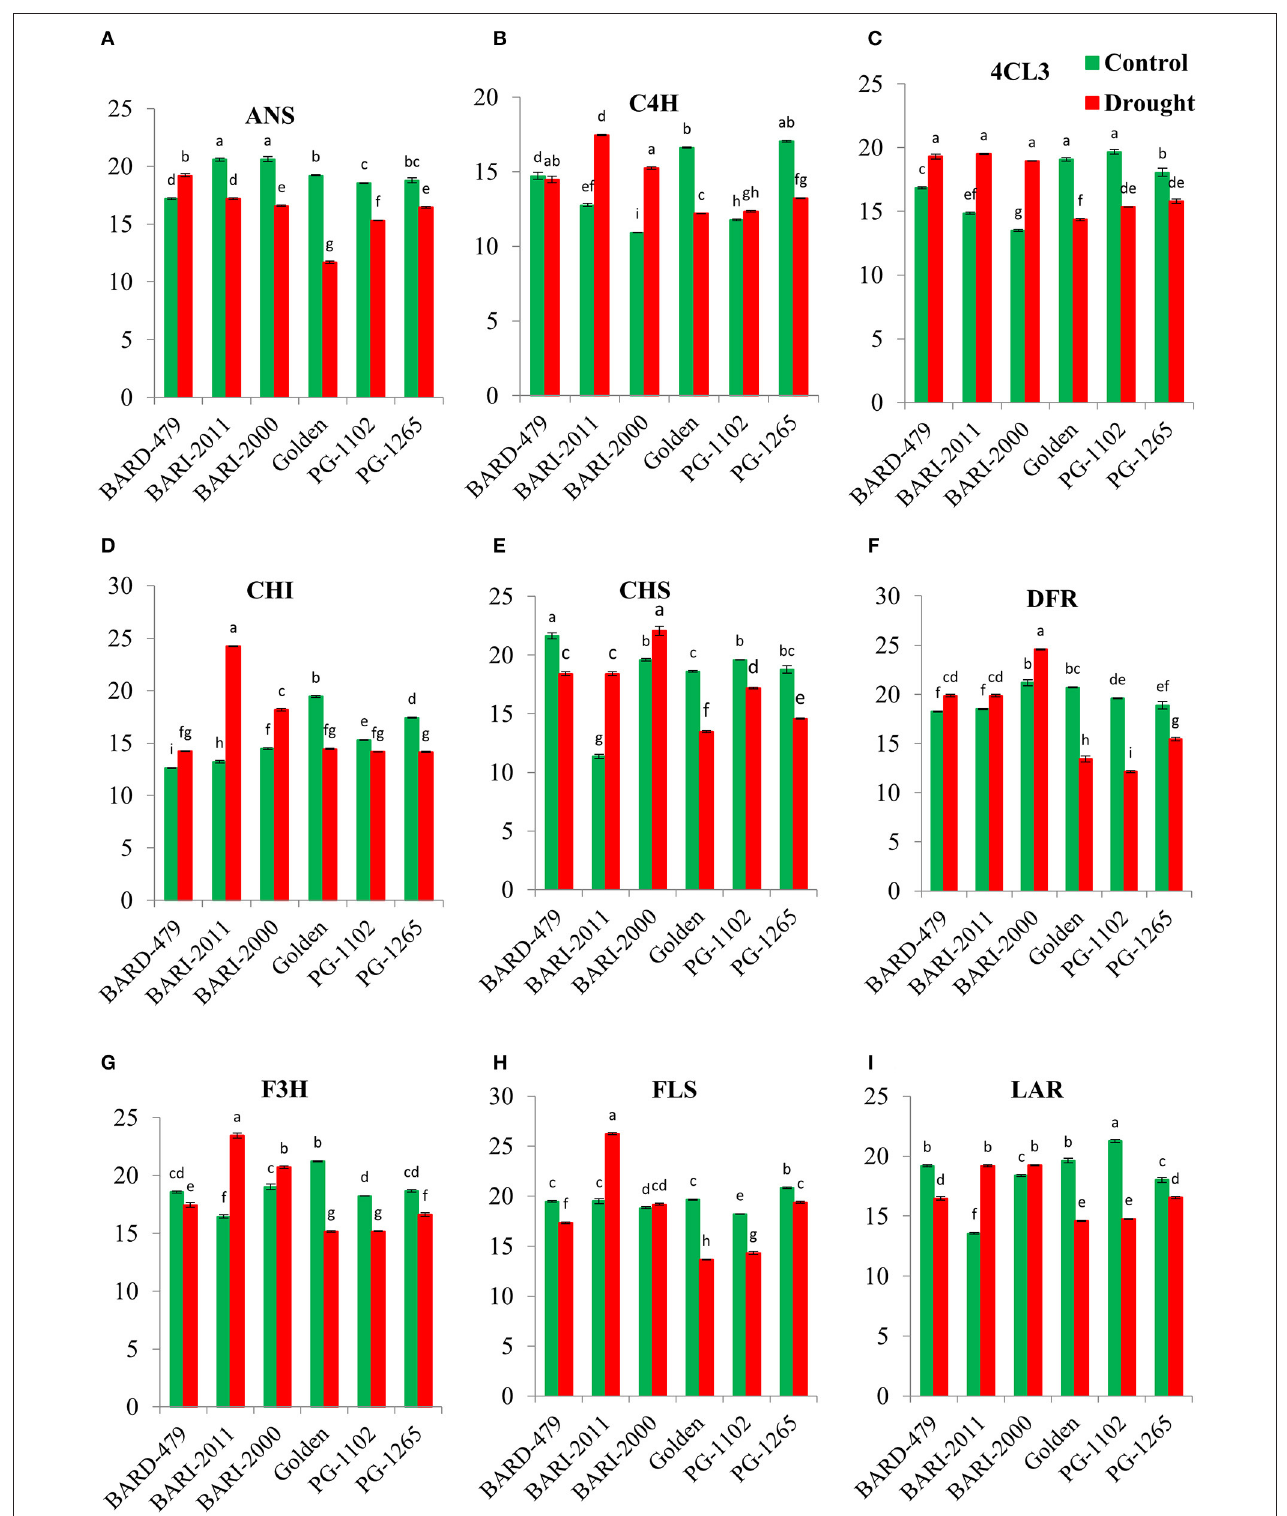
FIGURE 4 | Gene expression profile in roots of genotypes of peanuts under drought stress. The panel shows the following: the ANS (A) , the C4H (B) , the 4CL3 (C) , the CHI (D) , the CHS (E) , the DFR (F) , the F3H (G) , the FLS (H) , and the LAR (I) . Data are shown as the interaction between the genotypes of peanuts and the drought applied. Significance was inferred either with an ANOVA under the Tukey’s HSD post-hoc test for normally distributed data (Honest Significant Detection, p < 0.05). Non-parametric data were analyzed with a Kruskal–Wallis test under False Discovery Rate post-hoc correction (FDR, p < 0.05).